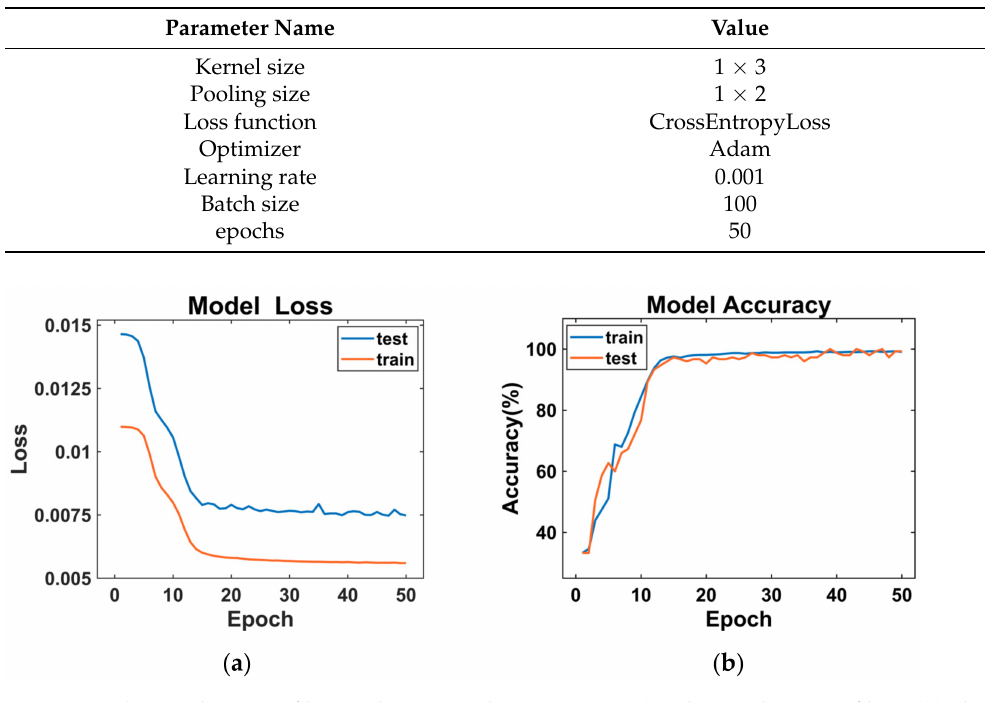
Figure 14. The trend curves of loss and accuracy during training. ( a ) The trend curves of loss. ( b ) The trend curves of